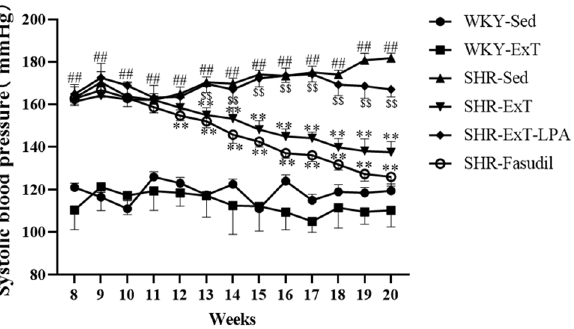
Figure 2. Systolic blood pressure (mmHg) of six groups. SHR-Sed SHR control group, WKY-Sed WKY control group, SHR-ExT SHR exercise group, WKY-ExT WKY exercise group, SHR-ExT-LPA SHR exercise plus LPA group; SHR-Fasudil SHR plus Fasudil group; Data are presented as mean ± SEM. n = 8 in each group. # P < 0.05, ## P < 0.01 vs WKY-Sed; $ P < 0.05, $$ P < 0.01 vs SHR-ExT; * P < 0.05, ** P < 0.01 vs